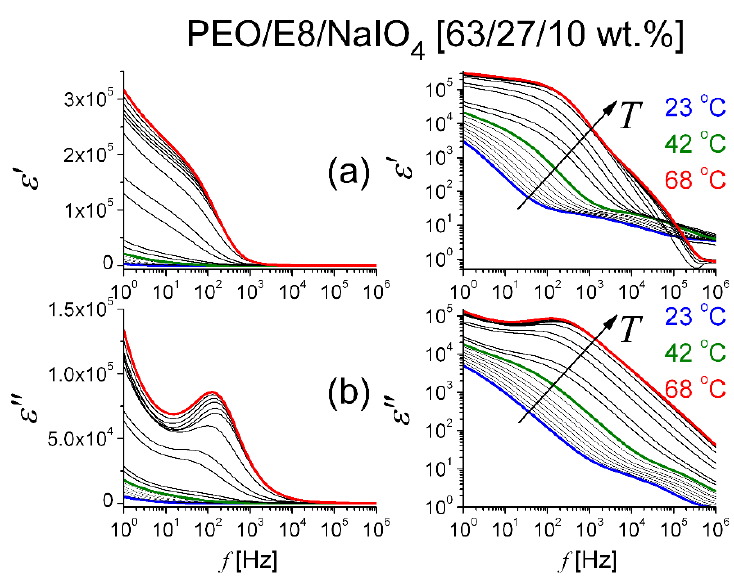
Figure 9. Frequency spectra of real ( a ) and imaginary ( b ) parts of complex dielectric permittivity for PEO/E8/NaIO 4 at various temperatures. Data for ε presented in linear ( left ) and logarithmic ( right ) scale. The arrows show the effect of increasing temperature.